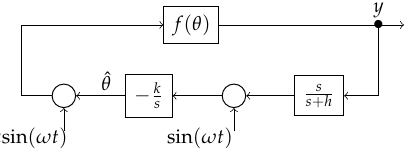
Figure 8. Basic ES scheme for a static map according to